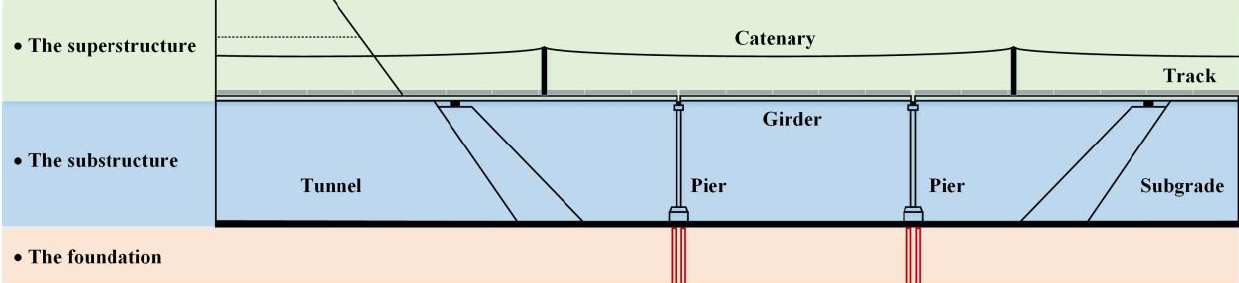
Figure 1. The sketch of high-speed railway structures.